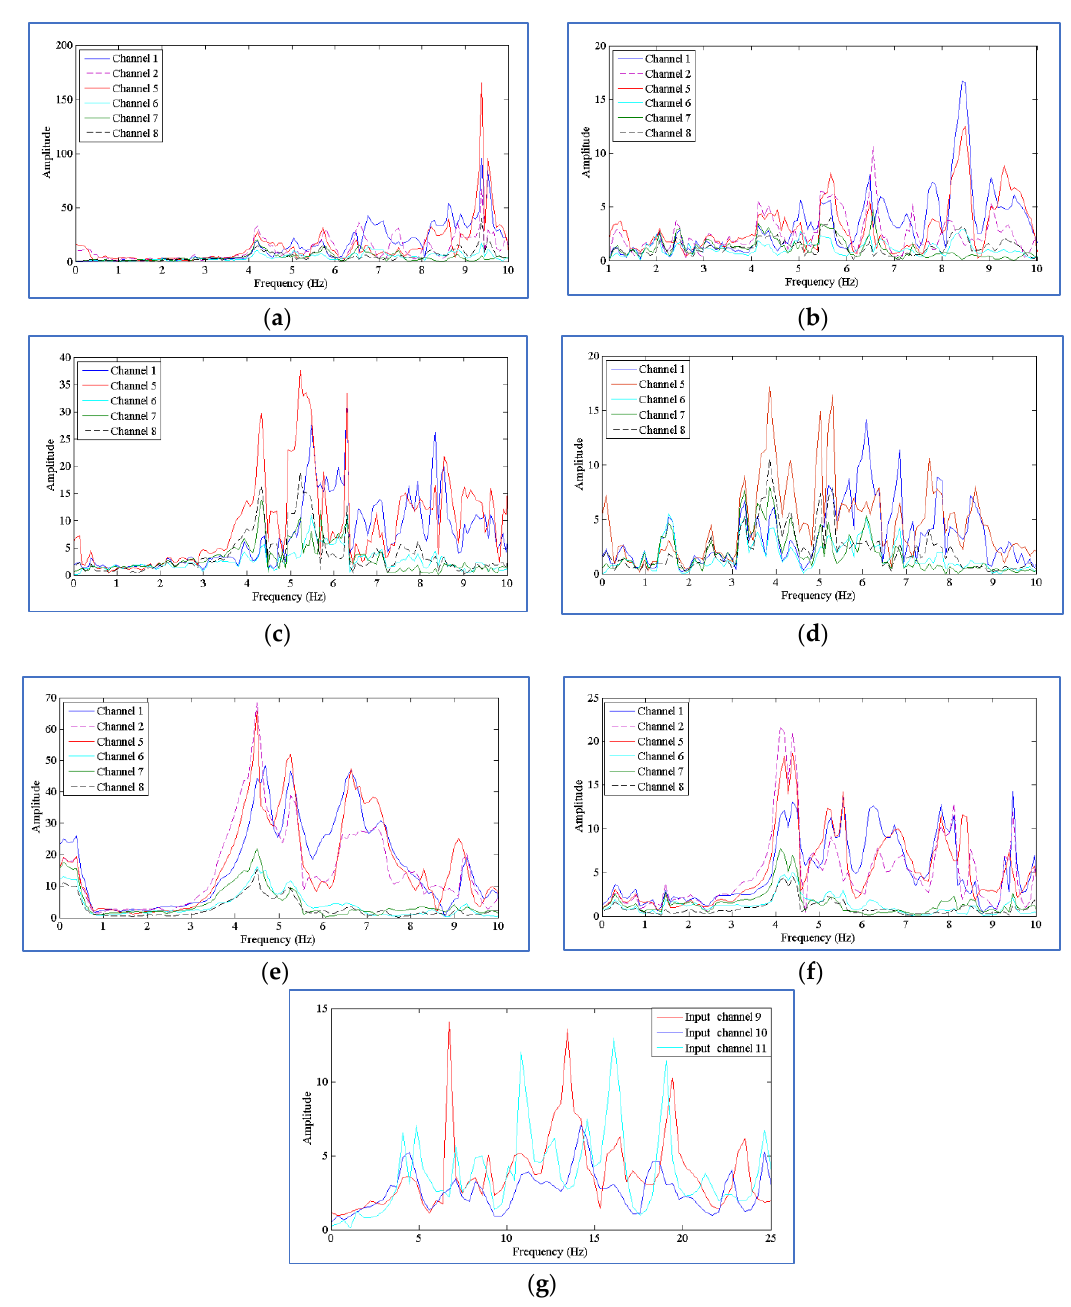
Figure 7. Structural frequency response function with different inputs: ( a ) 2011 Newhall earthquake,